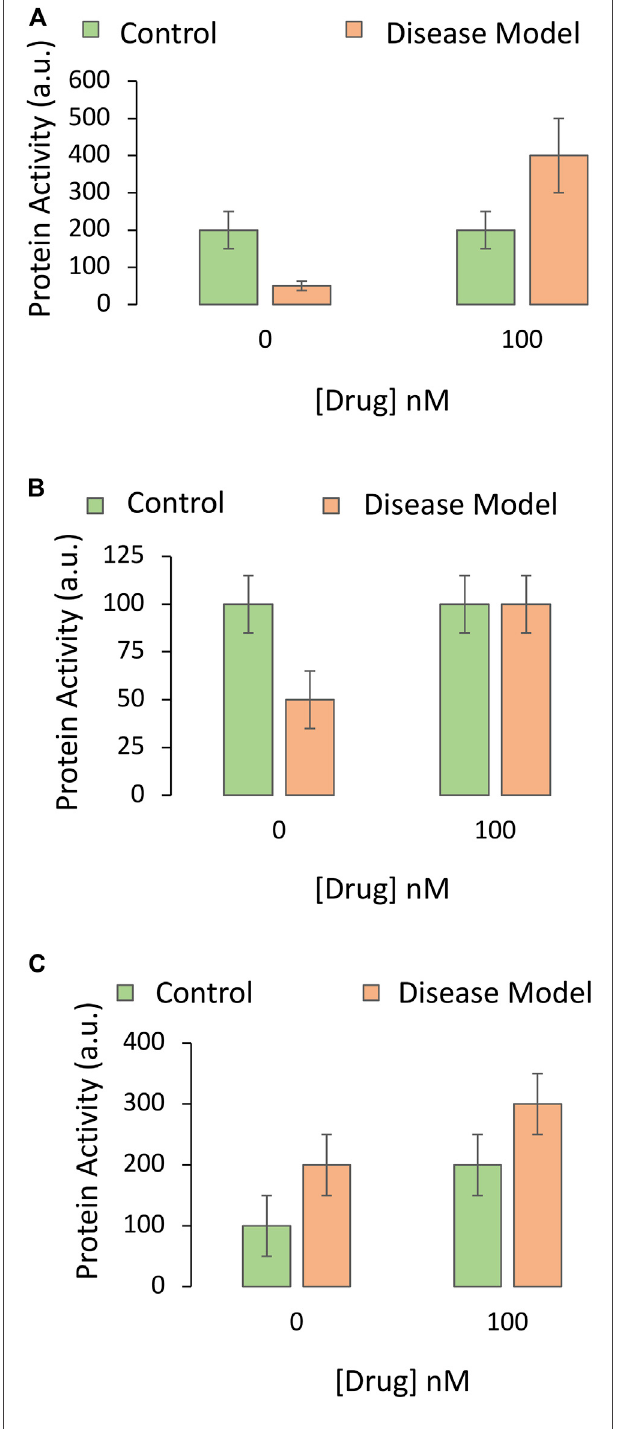
FIGURE2| Impactofthedrugcandidateontheactivityofadownstream targetproteininanexperimentaldiseasemodel.Aspeci fi candsensitiveassay is used to screen whether the pharmaceutical drug candidate increases the function of the protein hypothesized to mediate the protective impact of the drug against the experimental disease. The Y axis re fl ects protein activity levels (the dependent variable), and the X axis indicates one of the